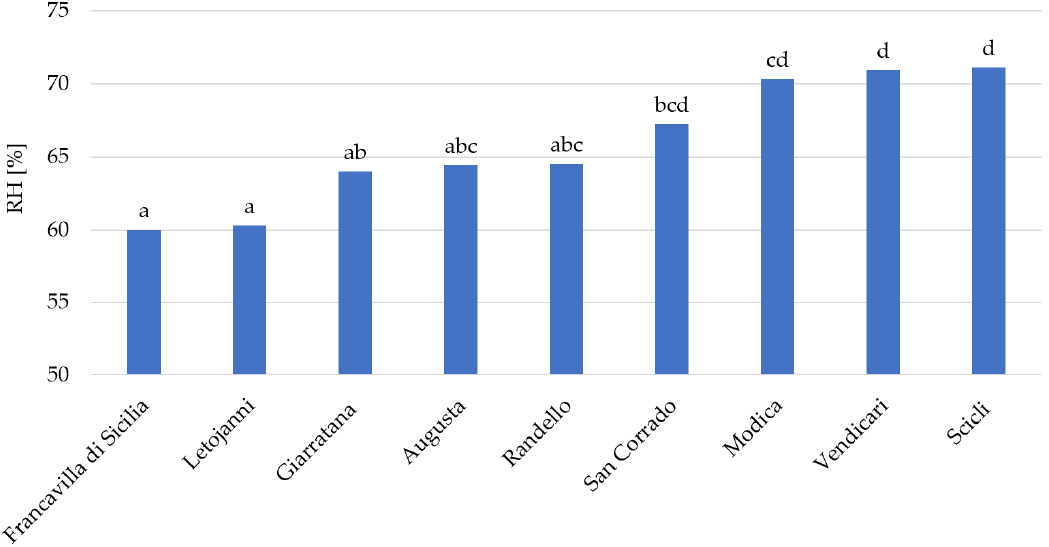
Figure 3. Differences in the mean monthly relative humidity among the nine sites under study. Letters represent significant differences. Sites sharing the same letter are not significantly different .